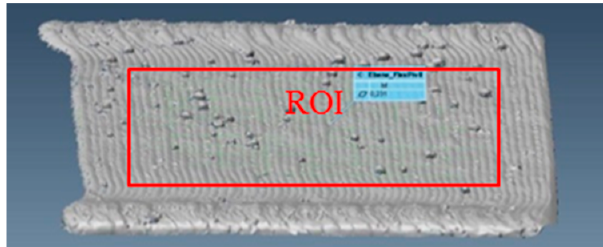
Figure 19. 3D scan and region of interest (ROI) to measure the flatness. Table 10. Flatness of surface measured with 3D scanning.